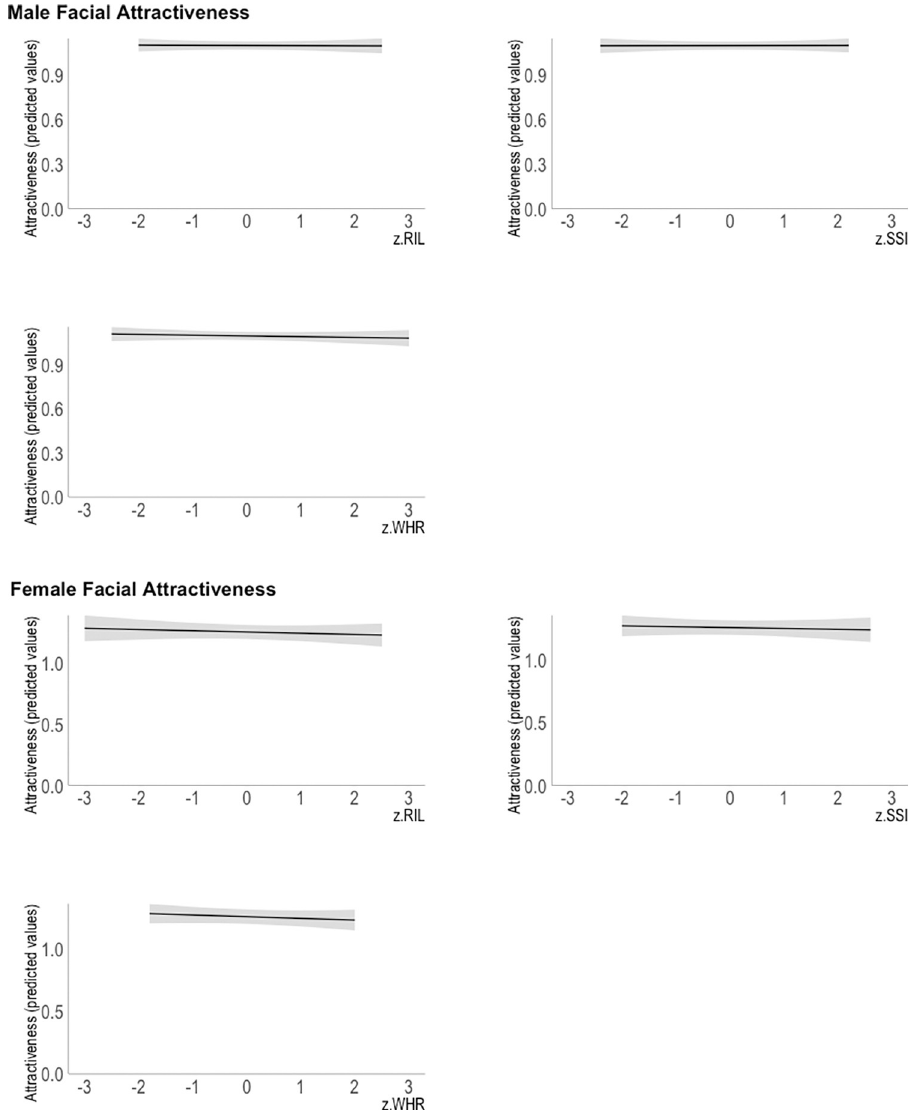
Fig 1. Relationship between transformed attractiveness (predicted values, adjusted for the means of other variables in the model) and z-scored (A) RIL, (B) SSI and (C) WHR in the male and female facial attractiveness model (MFA and FFA, respectively). The shaded area represents 95%